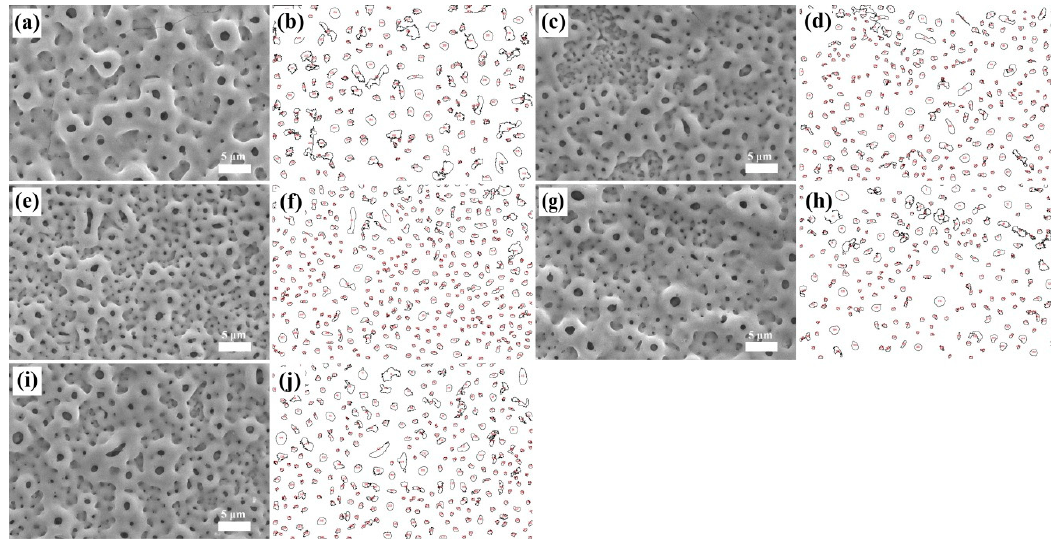
Figure 3. SEM images of MAO ‐ treated samples and their segmentation images obtained using software. ( a , b ): cp-Ti; ( c , d ): Ti-5Fe; ( e , f ): Ti-5Mo; ( g , h ): Ti-5V; ( i , j ): Ti-5Zr. Table 2. The pore parameters obtained using image analysis software. Table 2. The pore parameters obtained using image analysis